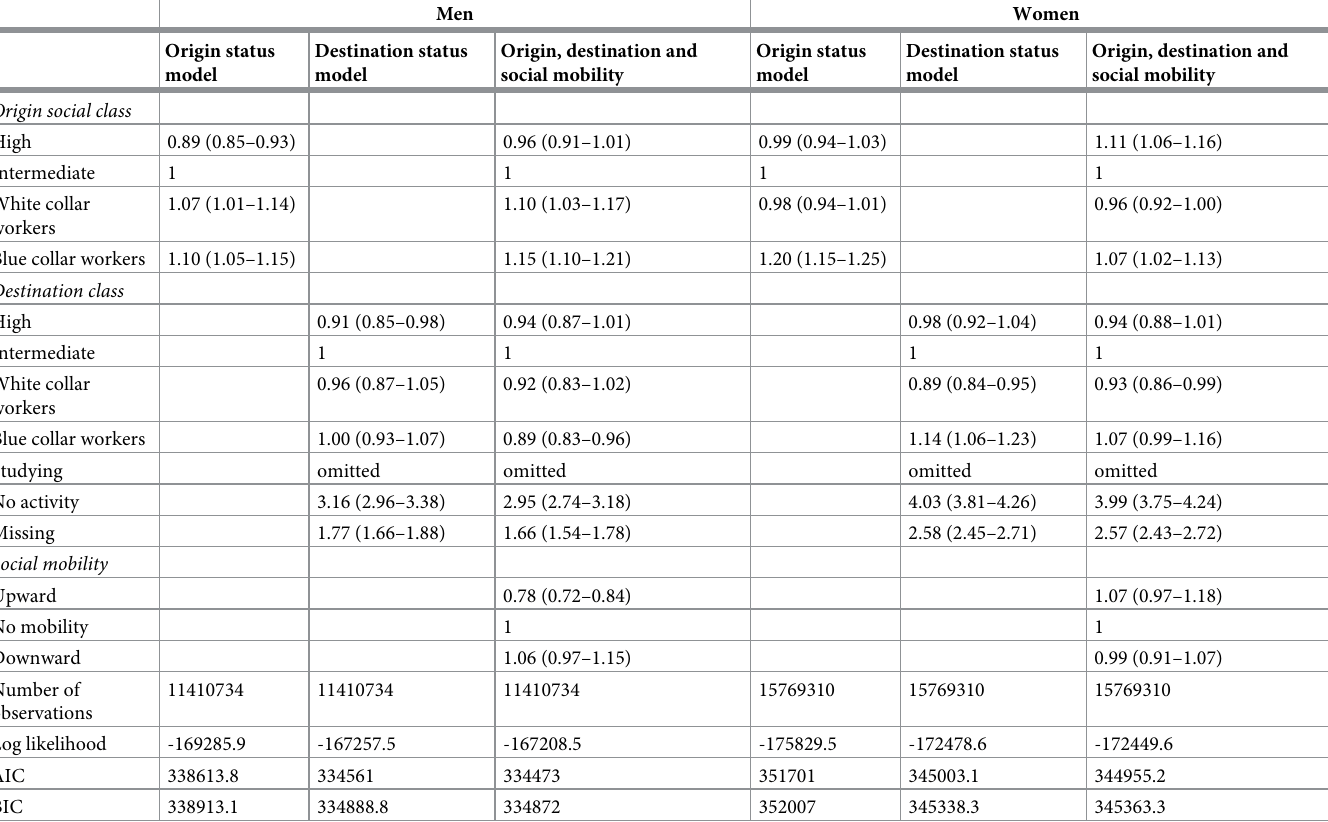
Table 4. Odds ratios (and 95% confidence intervals) from discrete time hazard analysis of all-cause mortality: Origin class, destination class and mobility, 1997 to 2012, adjusted for control